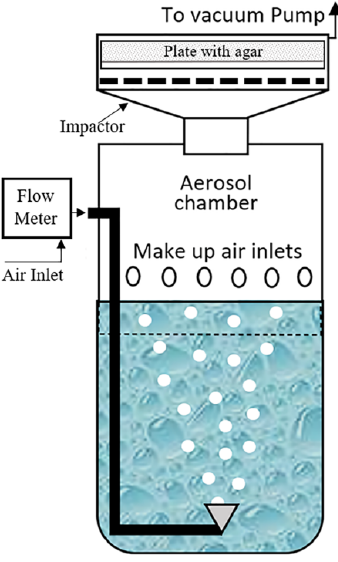
Figure 1. Schematic diagram of the experimental setup.